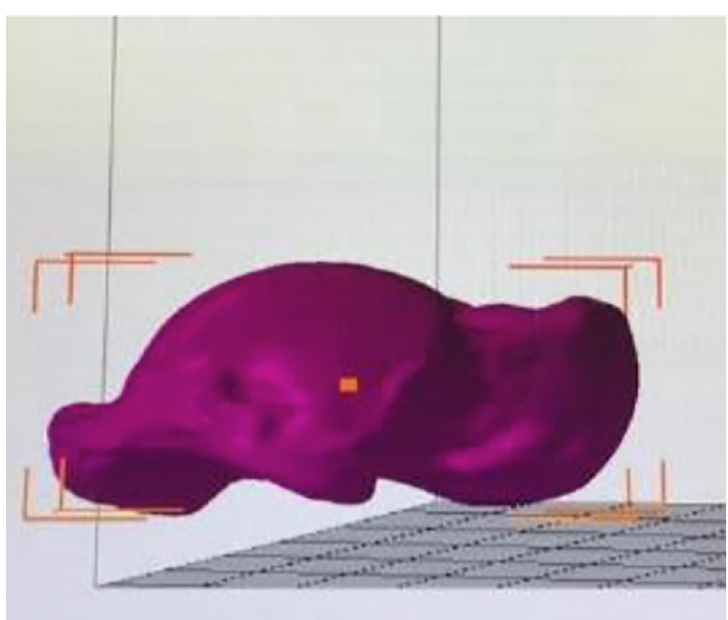
Fig 4. The image of scanned talus from the computer program (Autodesk Netfabb version 2020, USA) which was used to analyze the surface area and volume of each talus.